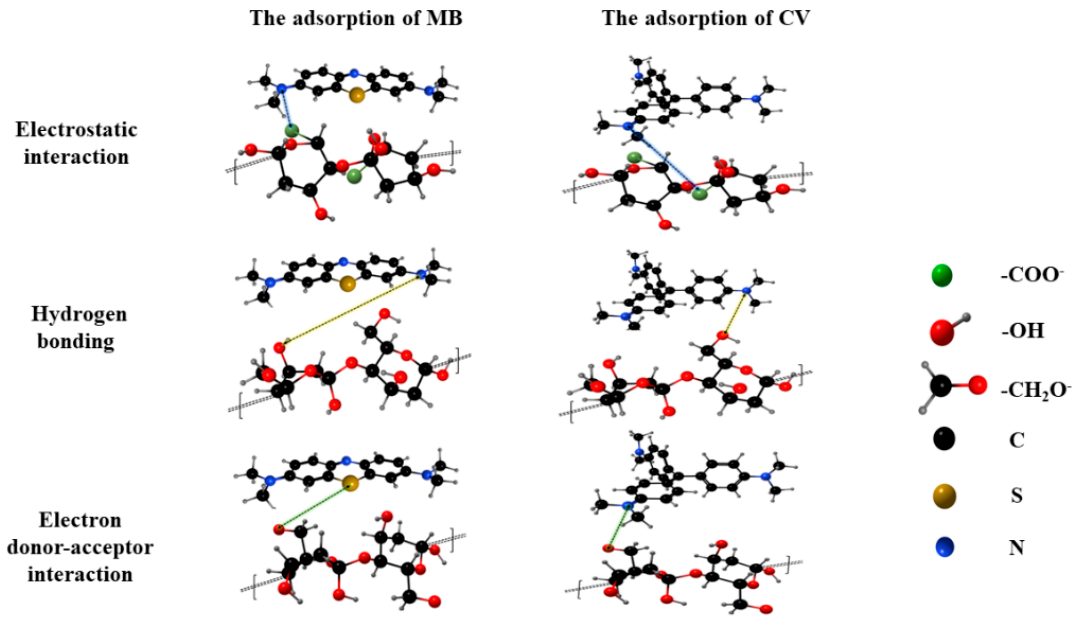
Figure 7. Possible adsorption